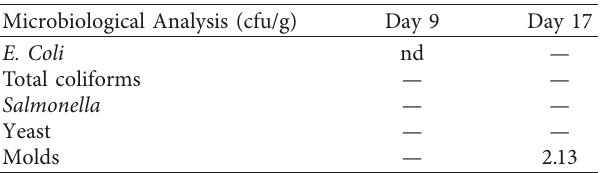
Table 8: Microbiological analysis of various gluten-free cupcakes ( T 4 only).